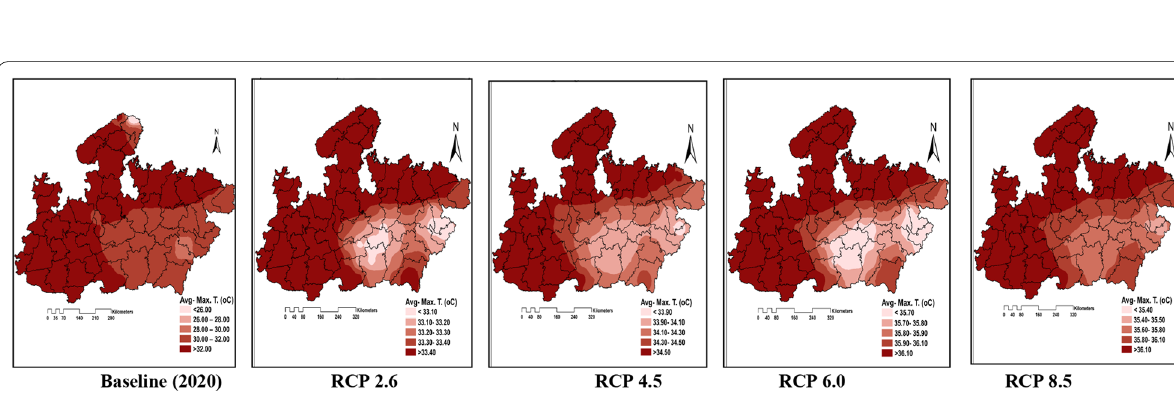
Fig. 8 Predicted change in the maximum temperature relative to baseline over the whole Madhya Pradesh state under different RCP scenarios of 2080. Under all the RCP scenarios, the average maximum temperature is projected to increase